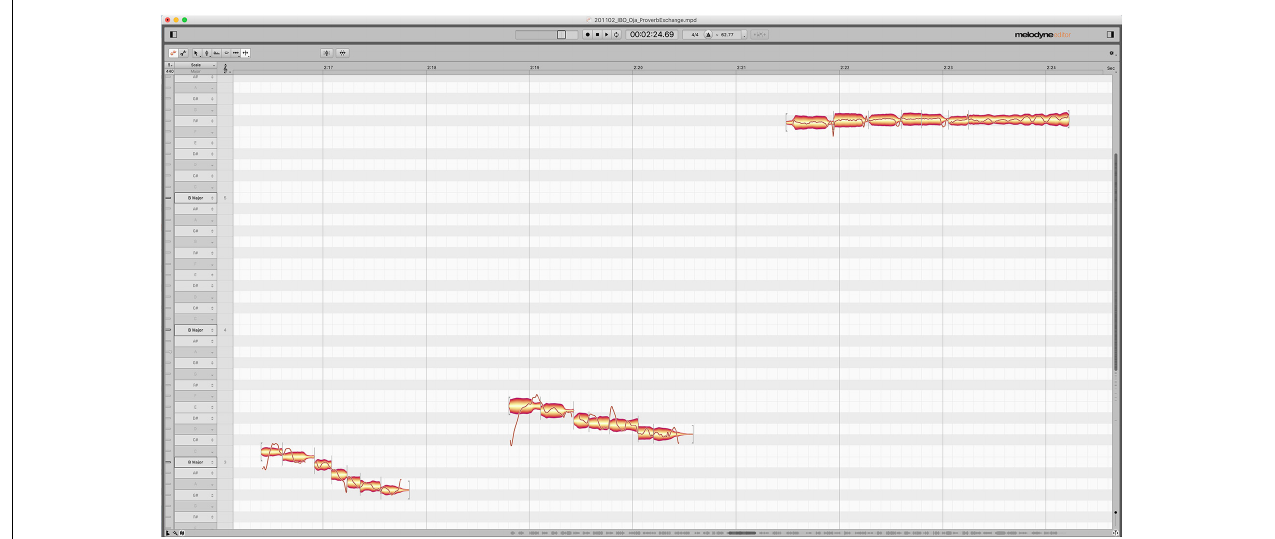
FIGURE 1 | Task 1–Phrase 7 in Melodyne with male voice (left) , female voice (middle) , and ò.jà (right)